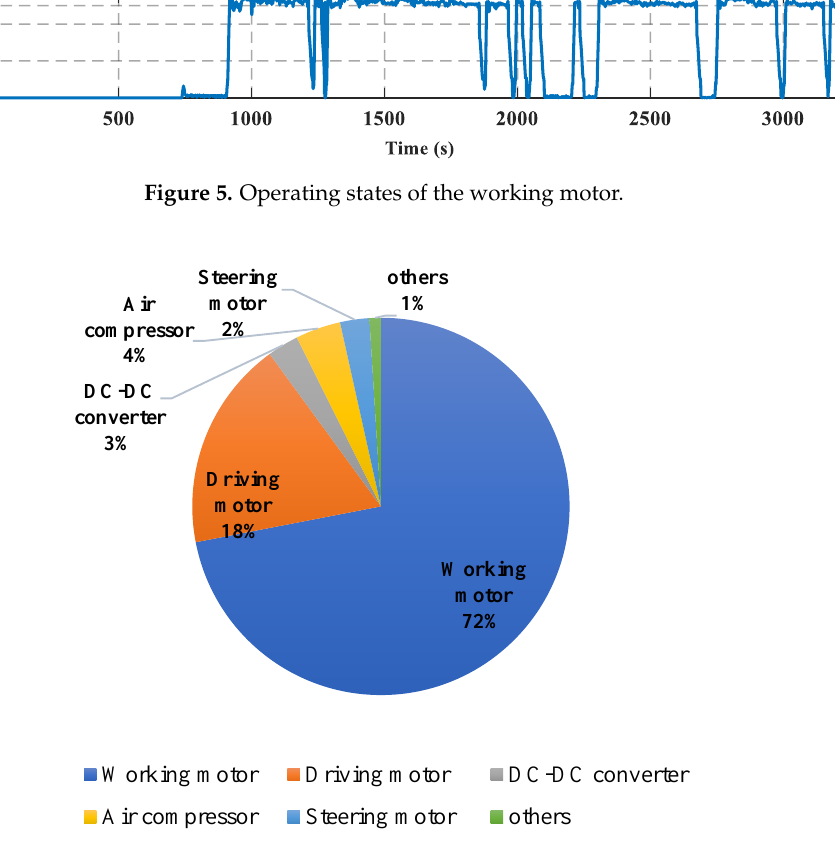
Figure 5. Operating states of the working motor.